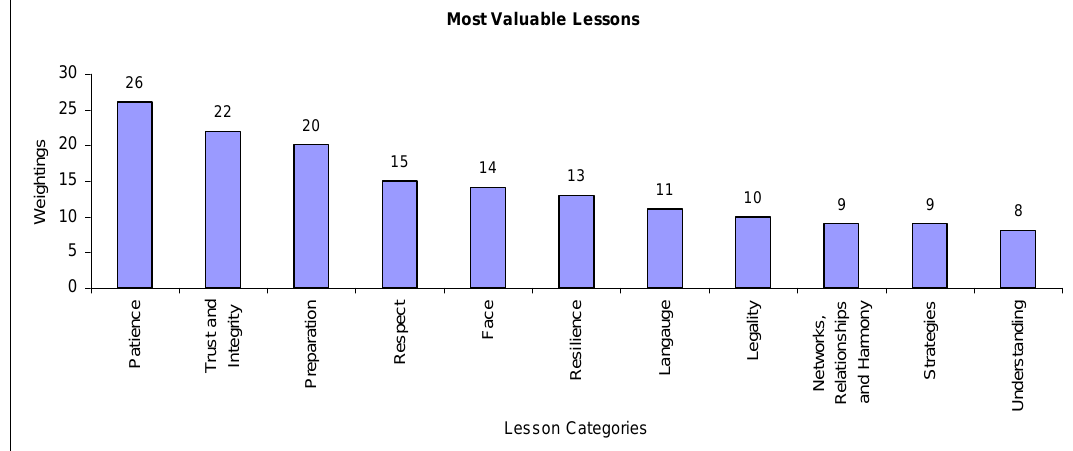
Figure 3: Most valuable South African negotiator lessons